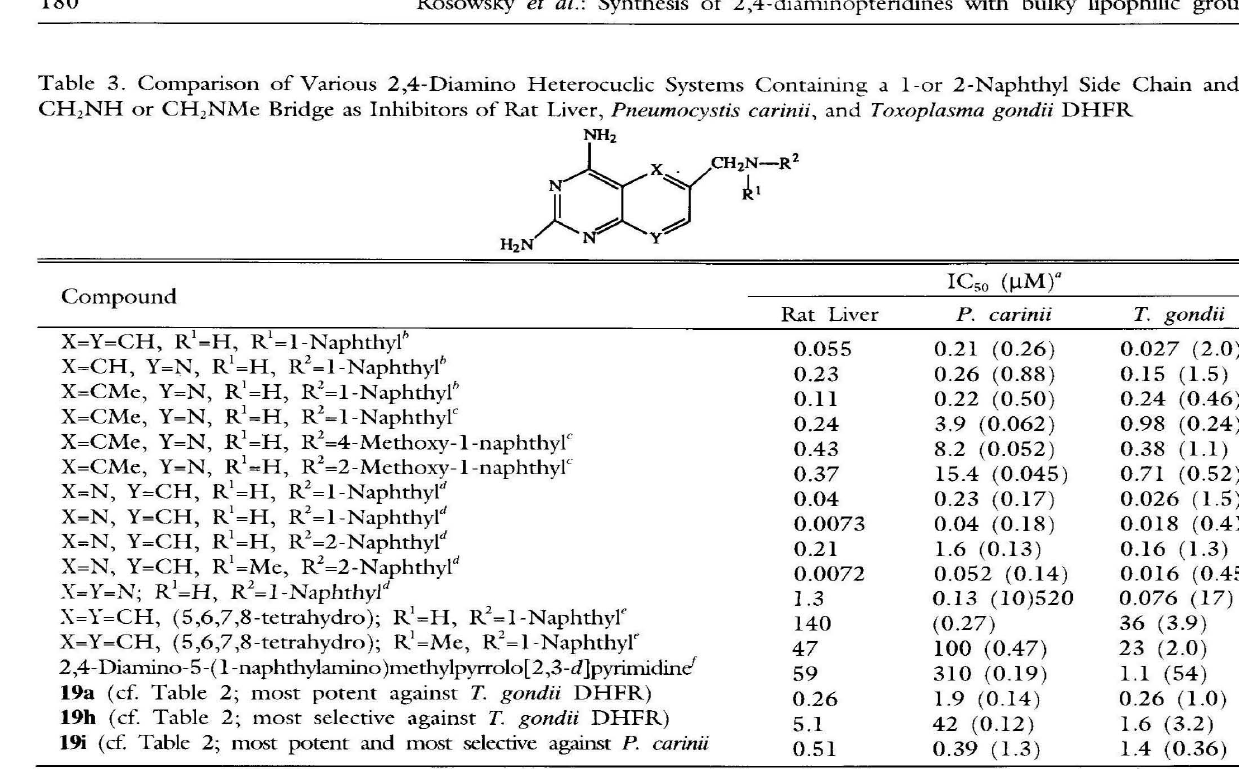
Table 3. Comparison of Various 2,4-Diamino Heterocuclic Systems Containing a I-or 2-Naphthyl Side Chain and a CH2NH or CH 2 NMe Bridge as Inhibitors of Rat Liver, Pneumocystis carinii, and Toxoplasma gondii DHFR